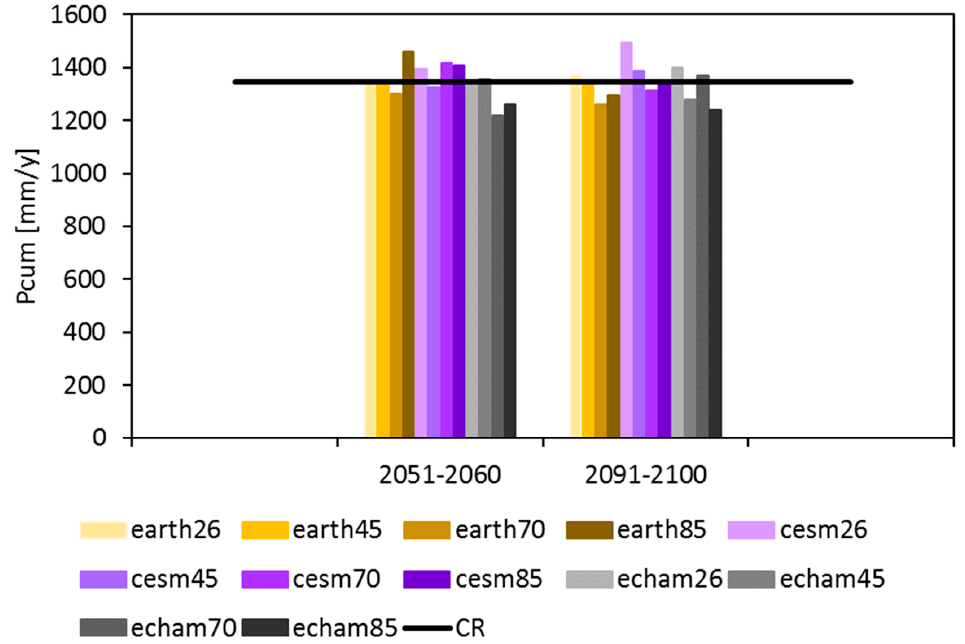
Figure 8. Projected total precipitation on the catchment for each SSP and each GCM.